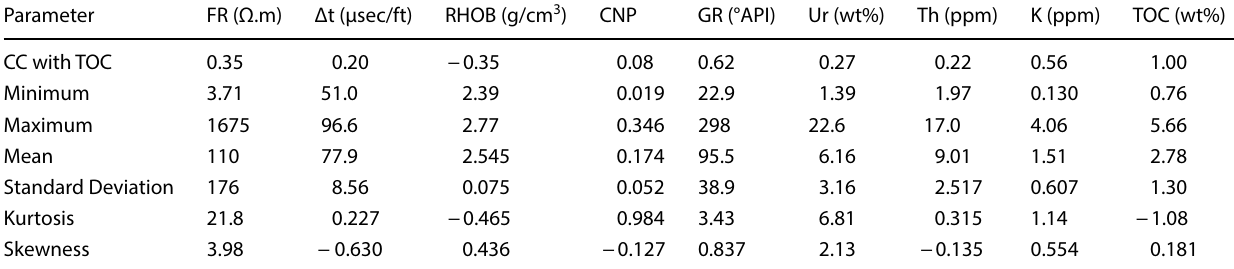
Table 3 Statistics of Well-I data